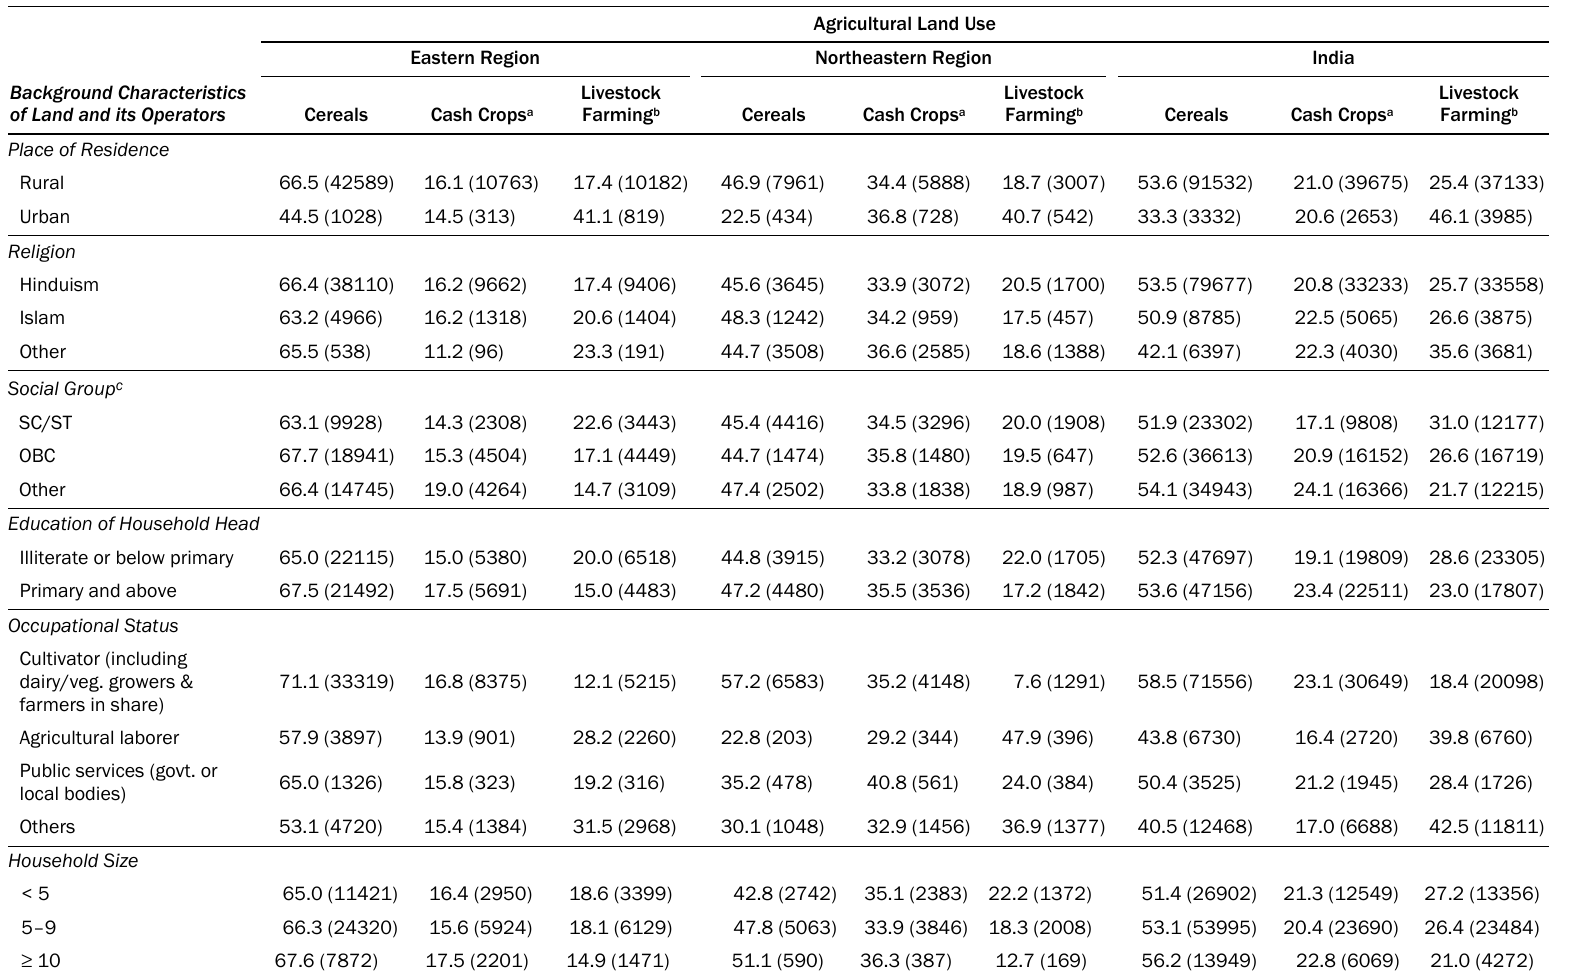
Table 2. Proportion (%) of Agricultural Plots (N) Used for Cereals, Cash Crops, and Livestock Farming, by Selected Background Characteristics, for Eastern and Northeastern Regions and All of India, 2003